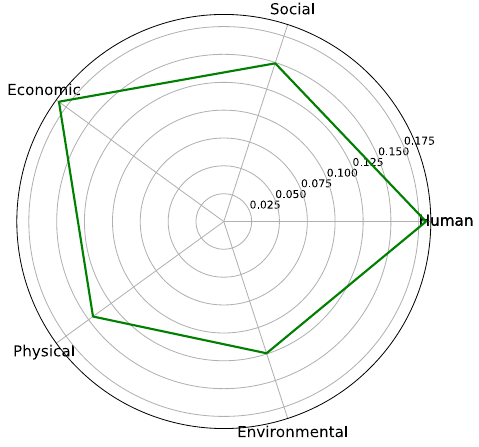
Figure 5. Key factor results of CMDRI.